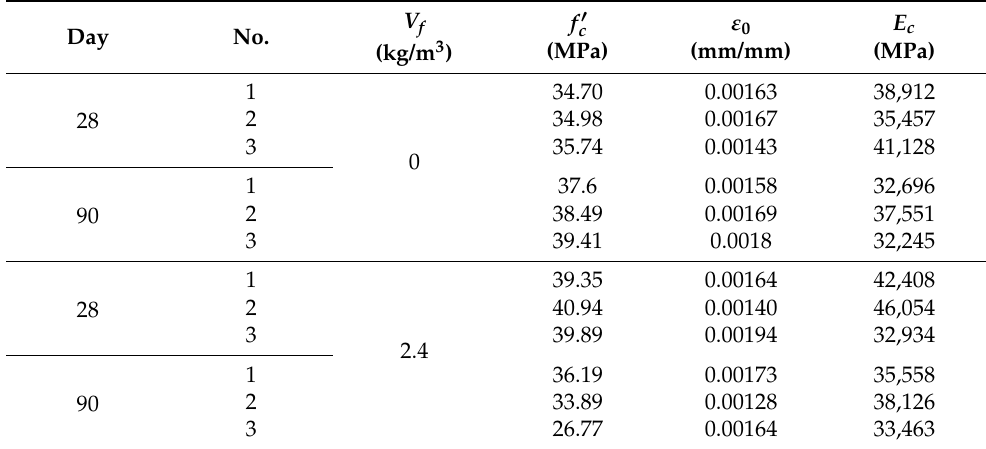
Table 4. Concrete compressive test results.